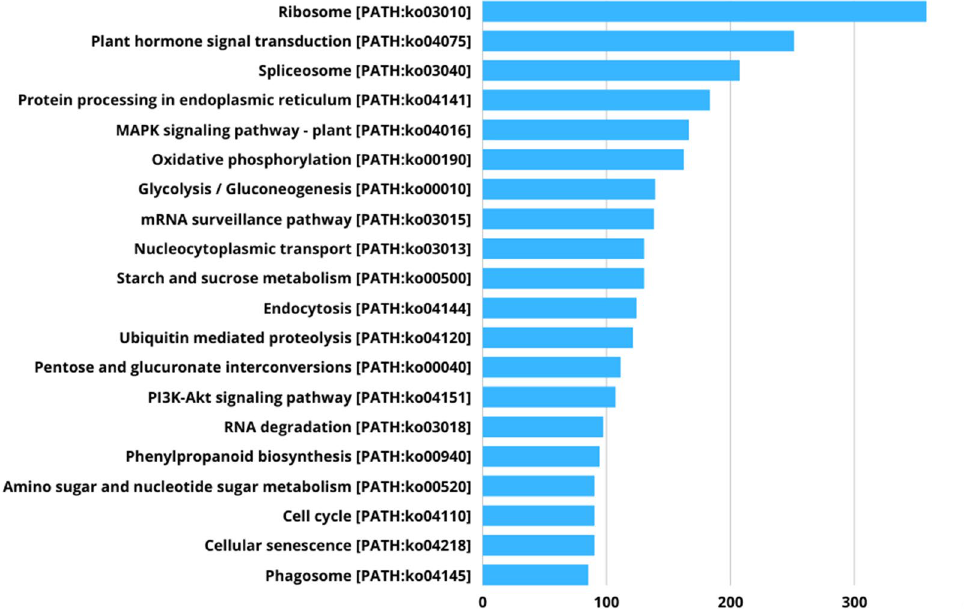
Figure 3. KEGG analysis of cashew genome showing the top 25 highly represented KEGG pathways. The X-axis indicates the KEGG pathways and the Y-axis indicates the number of transcripts in each pathway.